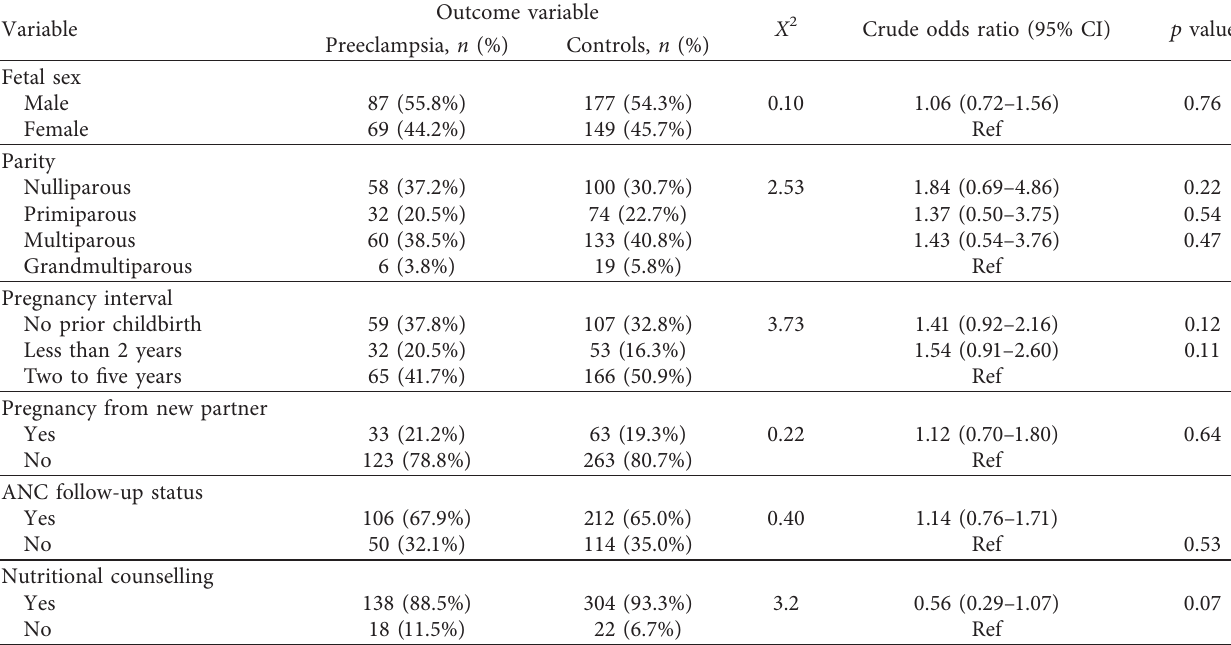
Table 3: Obstetric-related characteristics of women enrolled for a case-control study on factors of preeclampsia among pregnant women in Omo district hospitals, southern Ethiopia. The identified factors of